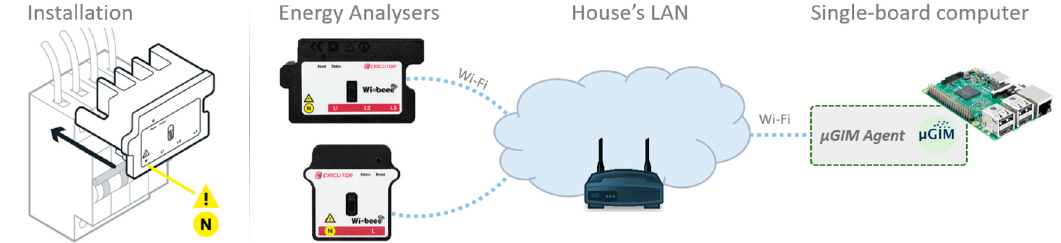
Figure 3. Installation of energy analysers and their integration with the µGIM agent.